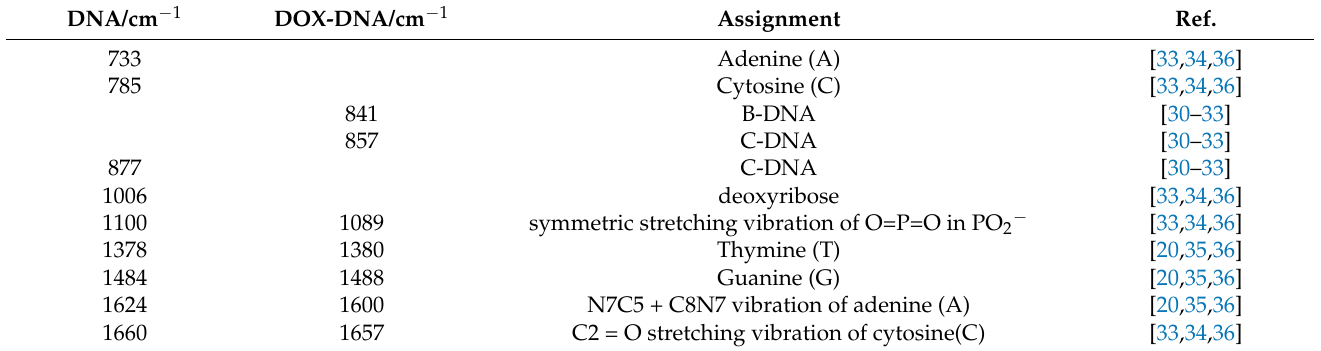
Table 1. Raman spectrum (wave number, cm − 1 ) and attribution of ctDNA and DOX interacting with ctDNA [20,30–36].